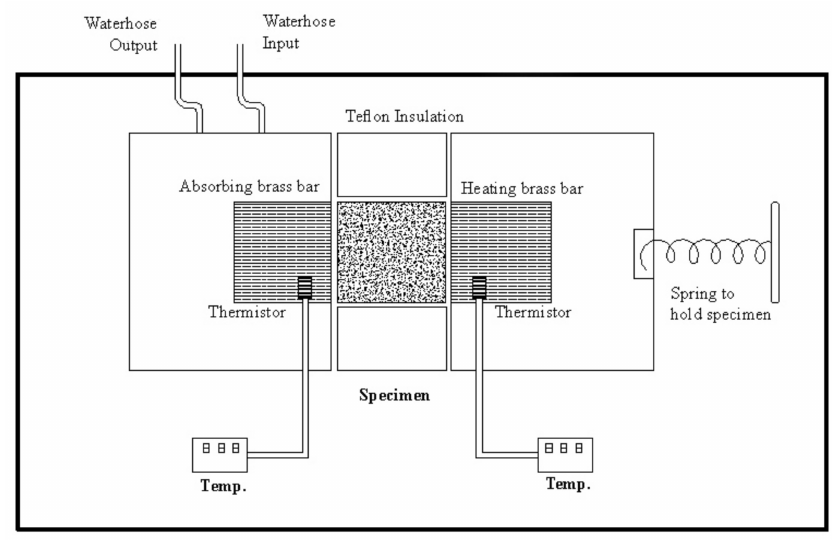
Schematic representation of the apparatus used for the measurement of thermal conductivity